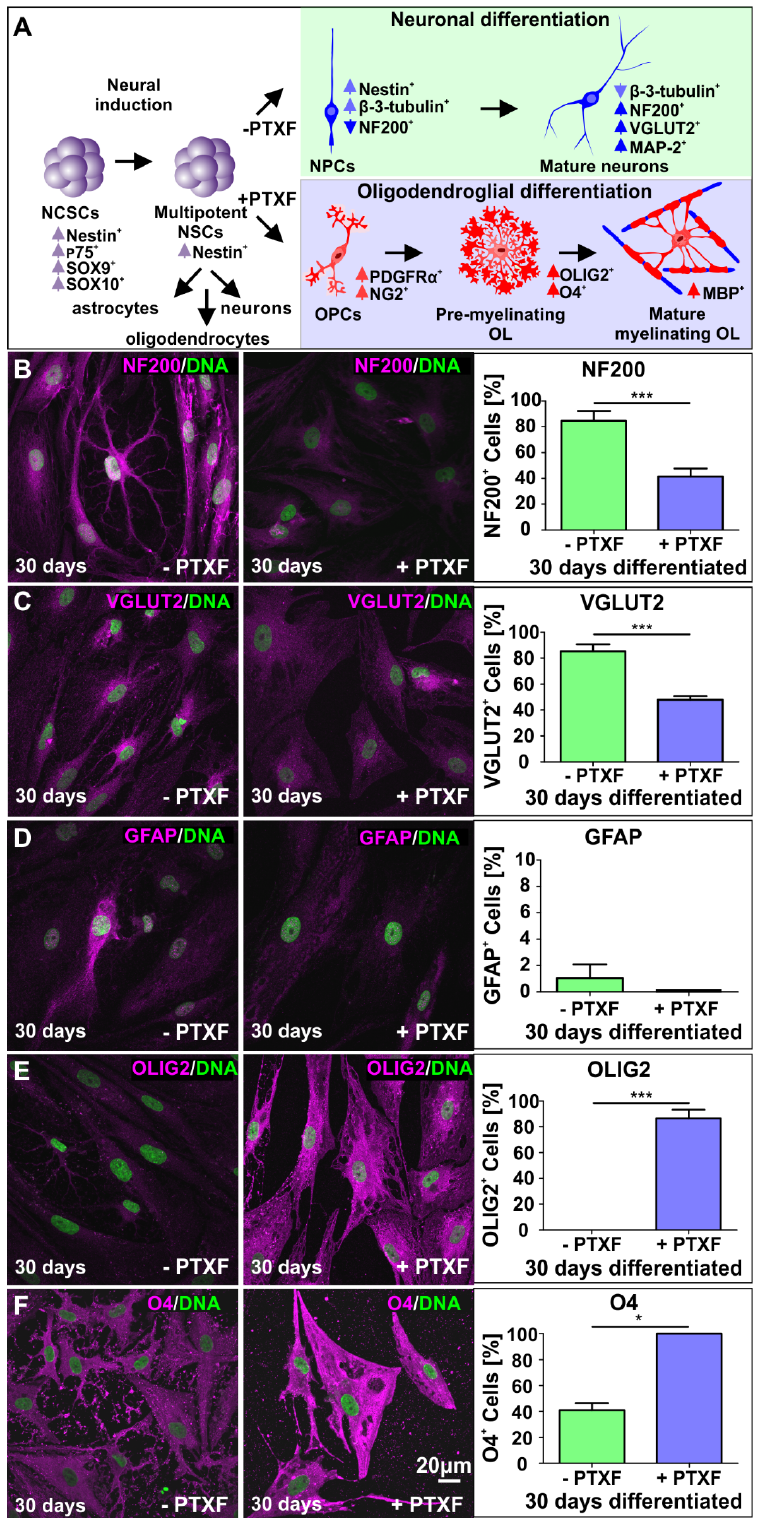
Figure4. Immunocytochemicalanalysisofneuronalandglialmarkersafterglutamatergicdi ff erentiation for 30 days in the presence or absence of pentoxifylline. ( A ) Transcription expression changes